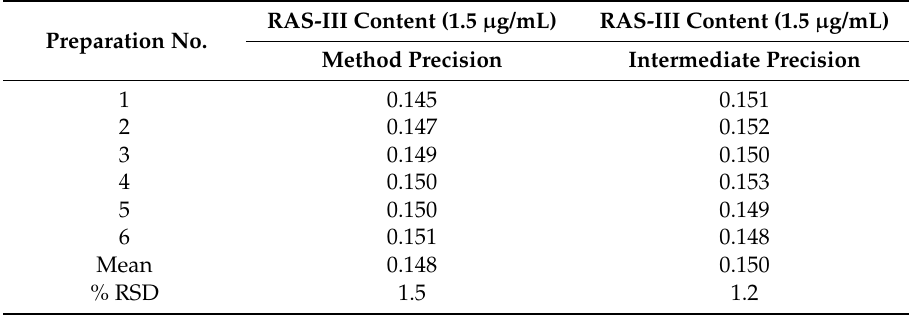
Table 3. Method and intermediate precision results for S -rasagiline